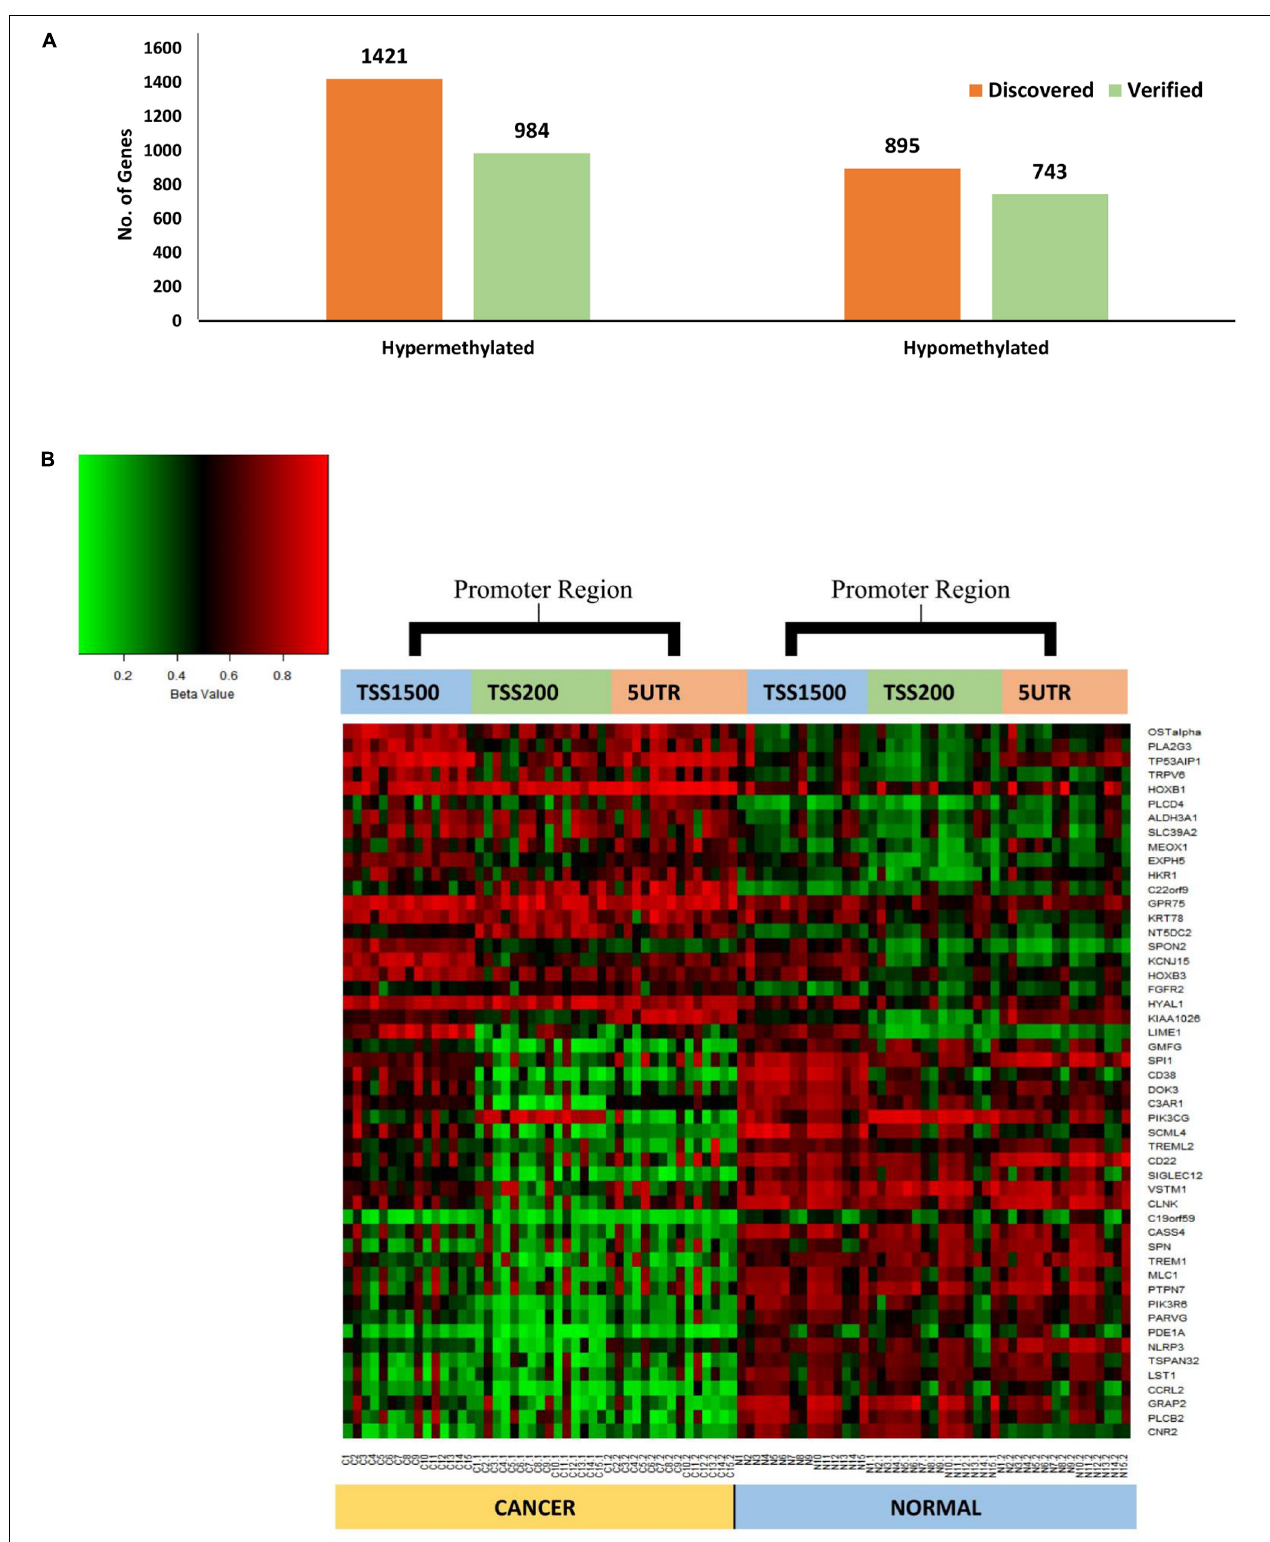
FIGURE 3 | (A) Chart showing the comparison between the number of discovered and validated genes, 69% ( n = 984) and 88% ( n = 743) of hypermethylated and hypomethylated genes respectively, were verified. (B) Heat map of the common significantly differentially methylated genes ( n = 50) in the promoter region (TSS1500, TSS200 and 5‘UTR) showing clear differential methylation between tumor and matched adjacent normal tissues. Unmethylated (0%) are represented by green whilst fully methylated (100%) are in red.